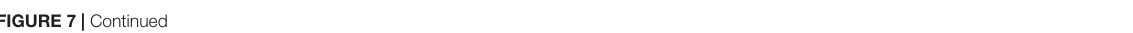
FIGURE 7 | Continued proteins. LHCs, light harvesting complexes; PSII, photosystem II; PSI, photosystem I; PPDK, pyruvate phosphate kinase; PEPC, phosphoenolpyruvate; CA, carbonic anhydrase; PRK, phosphoribulokinase; rbcL, Rubisco large subunit; rbcS, Rubisco small subunit; PGK, phosphoglycerate kinase; TKT2, fructose-bisphosphate aldolase; GAPDH, glyceraldehyde-3-phosphate dehydrogenase; pgm, phosphoglucomutase; GPI, glucose-6-phosphate isomerase;